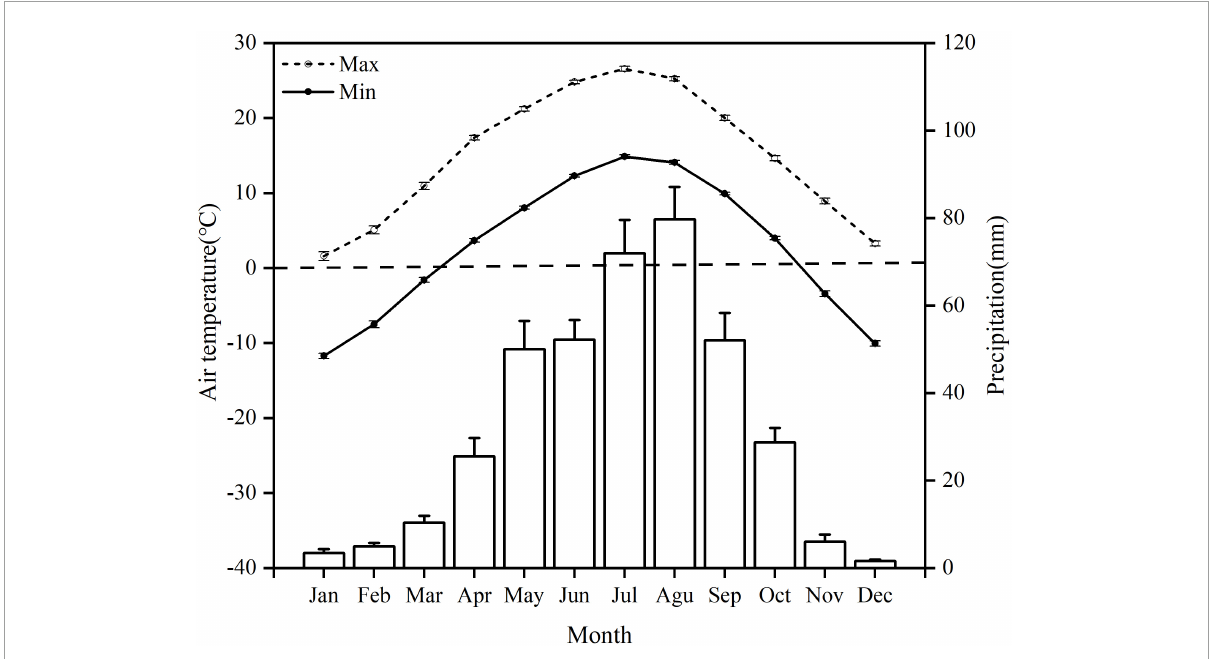
FIGURE1 Mean monthly maximum and minimum air temperatures (lines) and monthly precipitation (bars) for 1998–2018 at the study site. The error bars indicate standard errors.